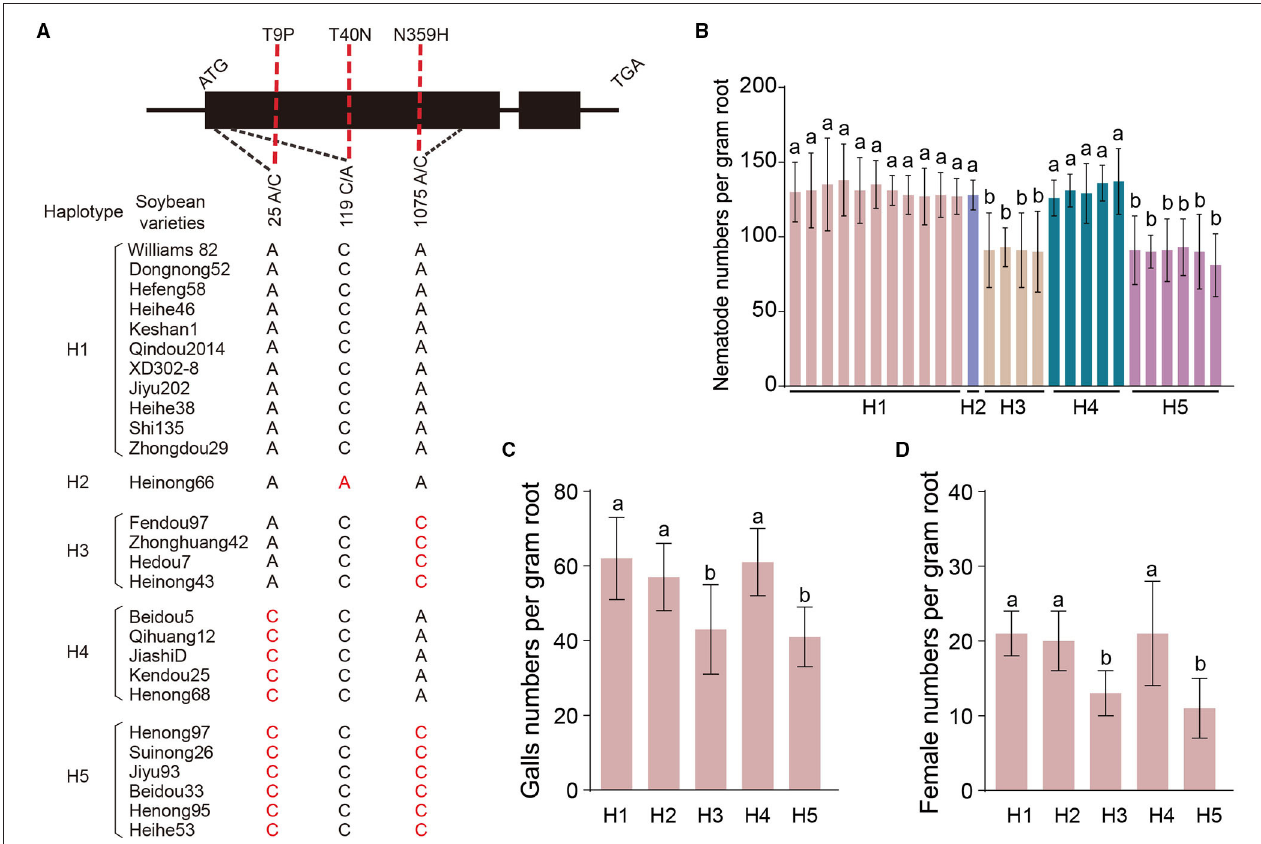
FIGURE 5 | Natural variation of GmLMM1 confers resistance against M. incognita . (A) Haplotypes identified at GmLMM1 in 27 soybean varieties. (B) M. incognita parasites numbers per gram of soybean roots at 7 dpi. (C,D) M. incognita gall (C) and female (D) numbers per gram of soybean roots at 30 dpi. At least three biological replicates of (B–D) were performed, and the similar results were obtained. Data are presented as the mean ± S.D., n ≥ 10; one-way ANOVA (different letters represent p <